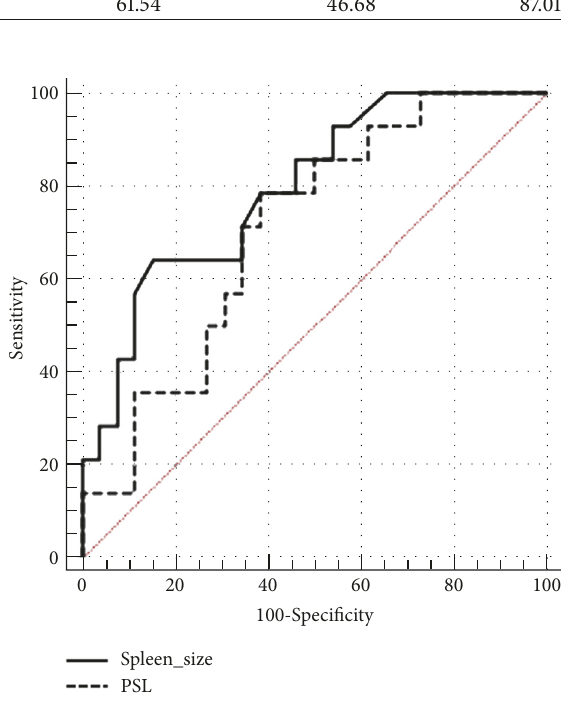
Figure 2: Comparison of AUROC for spleen size and PSL (platelet count/spleen length ratio) in prediction of HRV at gastroscopy. AUROC for spleen size was 0.809 (95% CI 0.658 – 0.913; p < 0.001). AUROC for PSL was 0.706 (95% CI 0.541 – 0.839, p = 0.014). The 𝑝 value for the comparison was